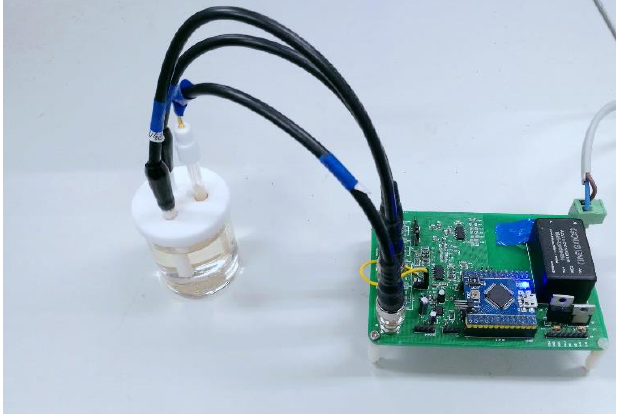
Figure 4. The designed voltammetry electronic tongue hardware system.